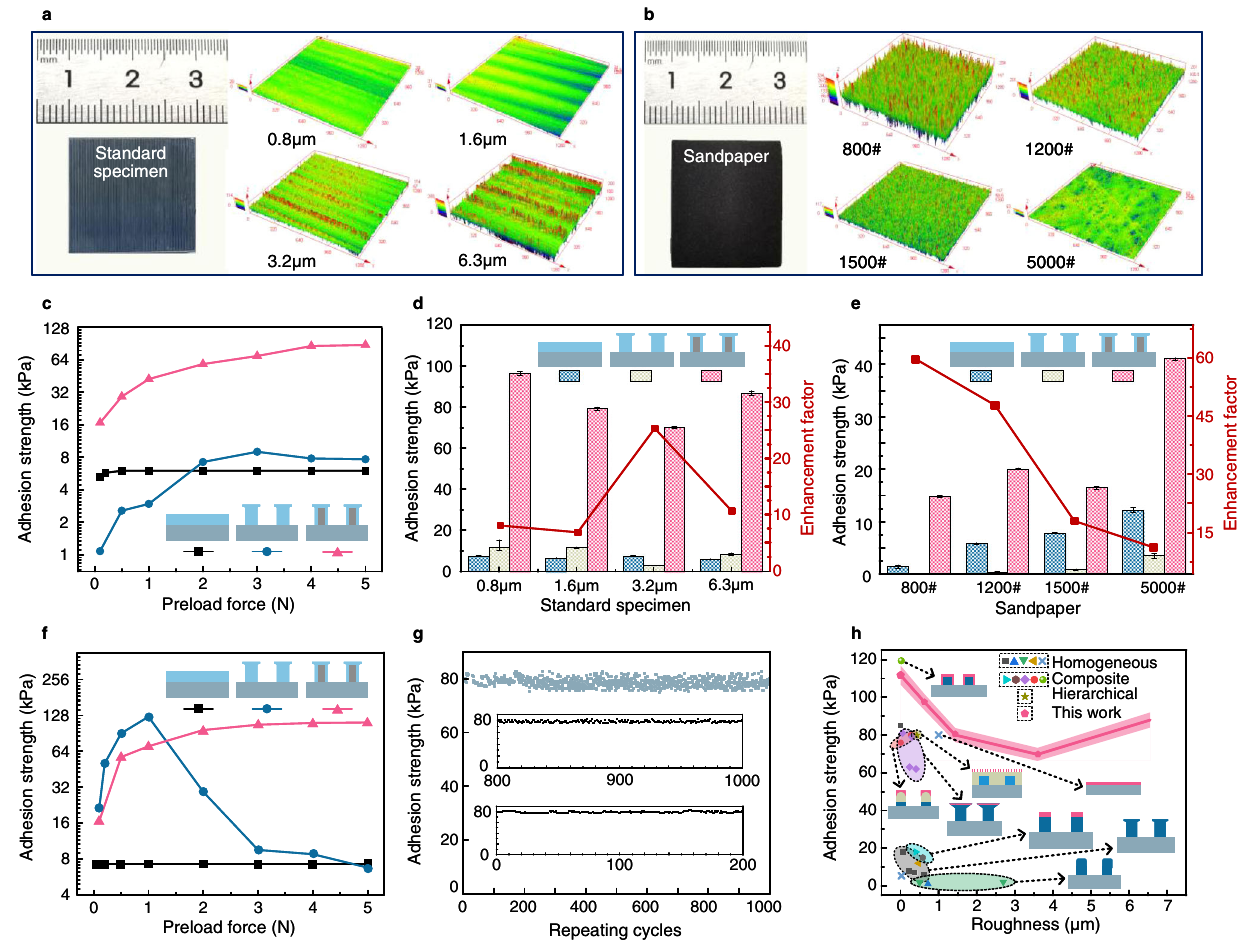
Fig.4 |Adhesionofthegrowncore – shellstructuresondiverseroughsurfaces. a , b Target rough surfaces used in the experiments, including standard specimens and sandpaper, respectively. c Variation in the adhesion strength as a function of the preload force for the tested samples, namely the core – shell structure, homo- geneous structure, and soft polymer fi lm. d , e Adhesion strength of the three samplesonstandardspecimensandsandpaper,respectively.Errorbarsarede fi ned